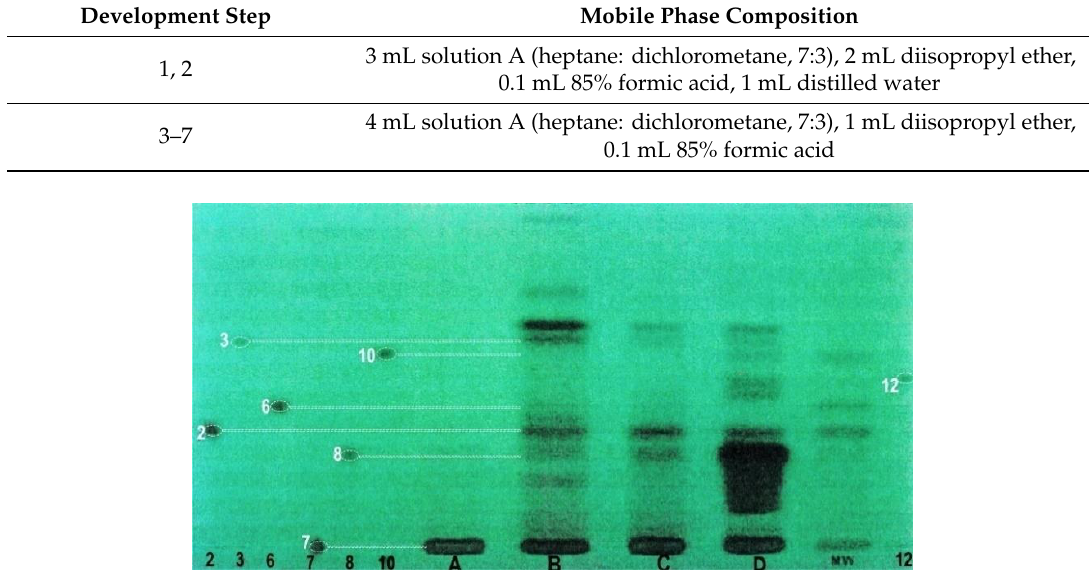
Figure 8. Separation of phenolic acids in methanol extracts of L. album subsp. album flowers. A —ethyl acetate extract-excluded from the investigations; B —methanol extract; C —acid hydrolysis; D —basic